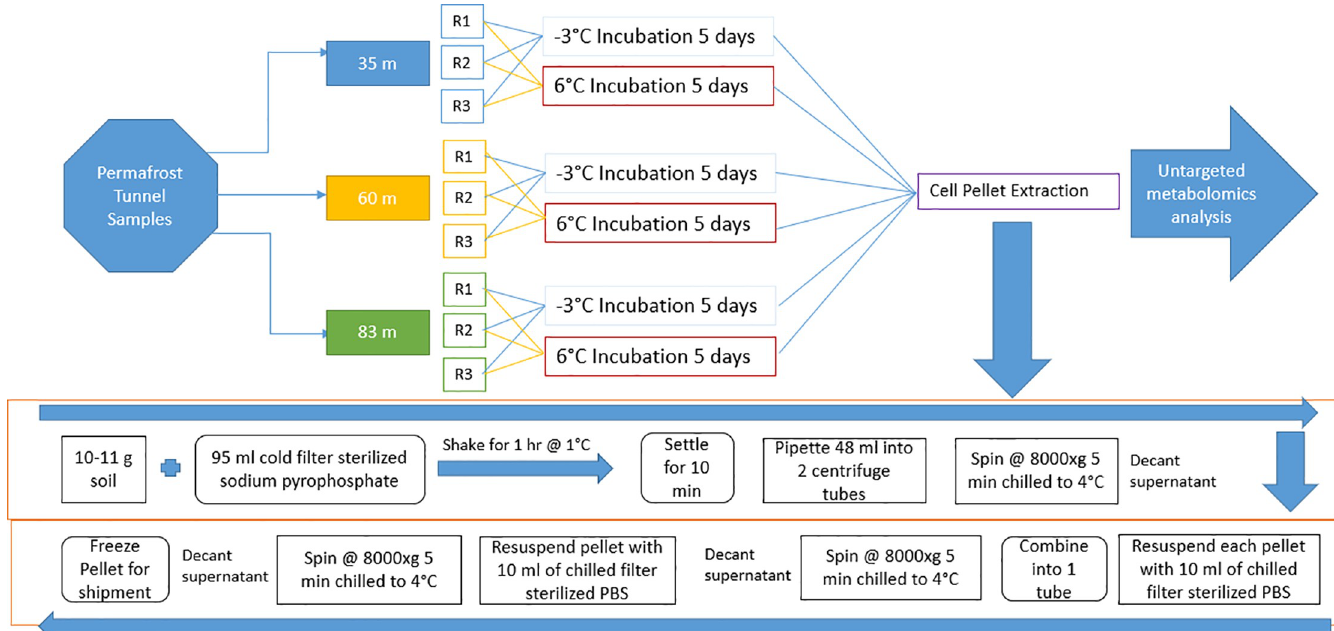
Fig 1. Schematic diagram of the procedure used for the experimental set-up and metabolome extraction. PBS denotes Phosphate Buffered Saline.